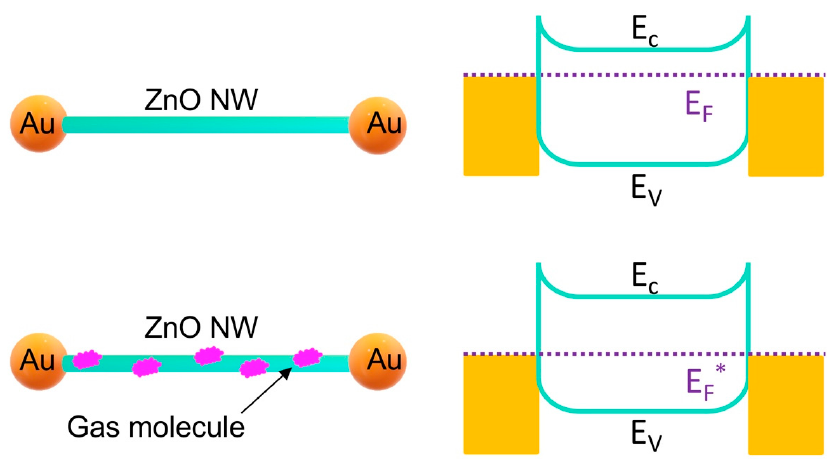
Figure 5. Mechanisms of room-temperature gas sensing based on the Au–ZnO (M-S) n network.